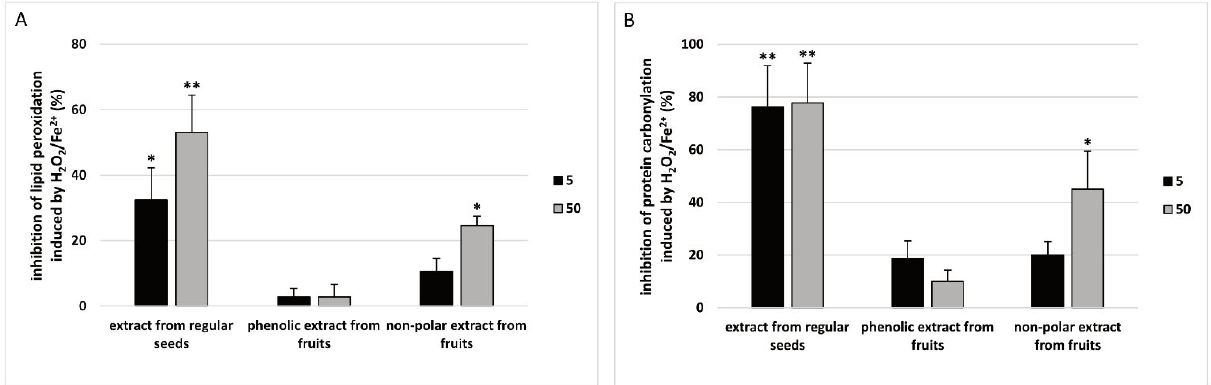
Figure 4. Effect of the extracts from regular and roasted sea buckthorn seeds (at concentrations 0.5, 5, and 50 μ g/mL) on white thrombus formation in whole blood ( n = 5). The samples were analyzed with T ‐ TAS AR ‐ chip, at the shear stress rates of 600/s. The results are presented as AUC 30 (area under the curve). The data are expressed as means ± SD. The results were considered significant at p < 0.05 (* p < 0.05). The number above the significant result is % of coagulation inhibition. ( A ). Effect of the extract from roasted sea buckthorn seeds (at concentrations 0.5, 5, and 50 μ g/mL) on coagula ‐ tion in whole blood; OT—occlusion time ( B ). Figure 4B demonstrates selected diagrams ( B ).